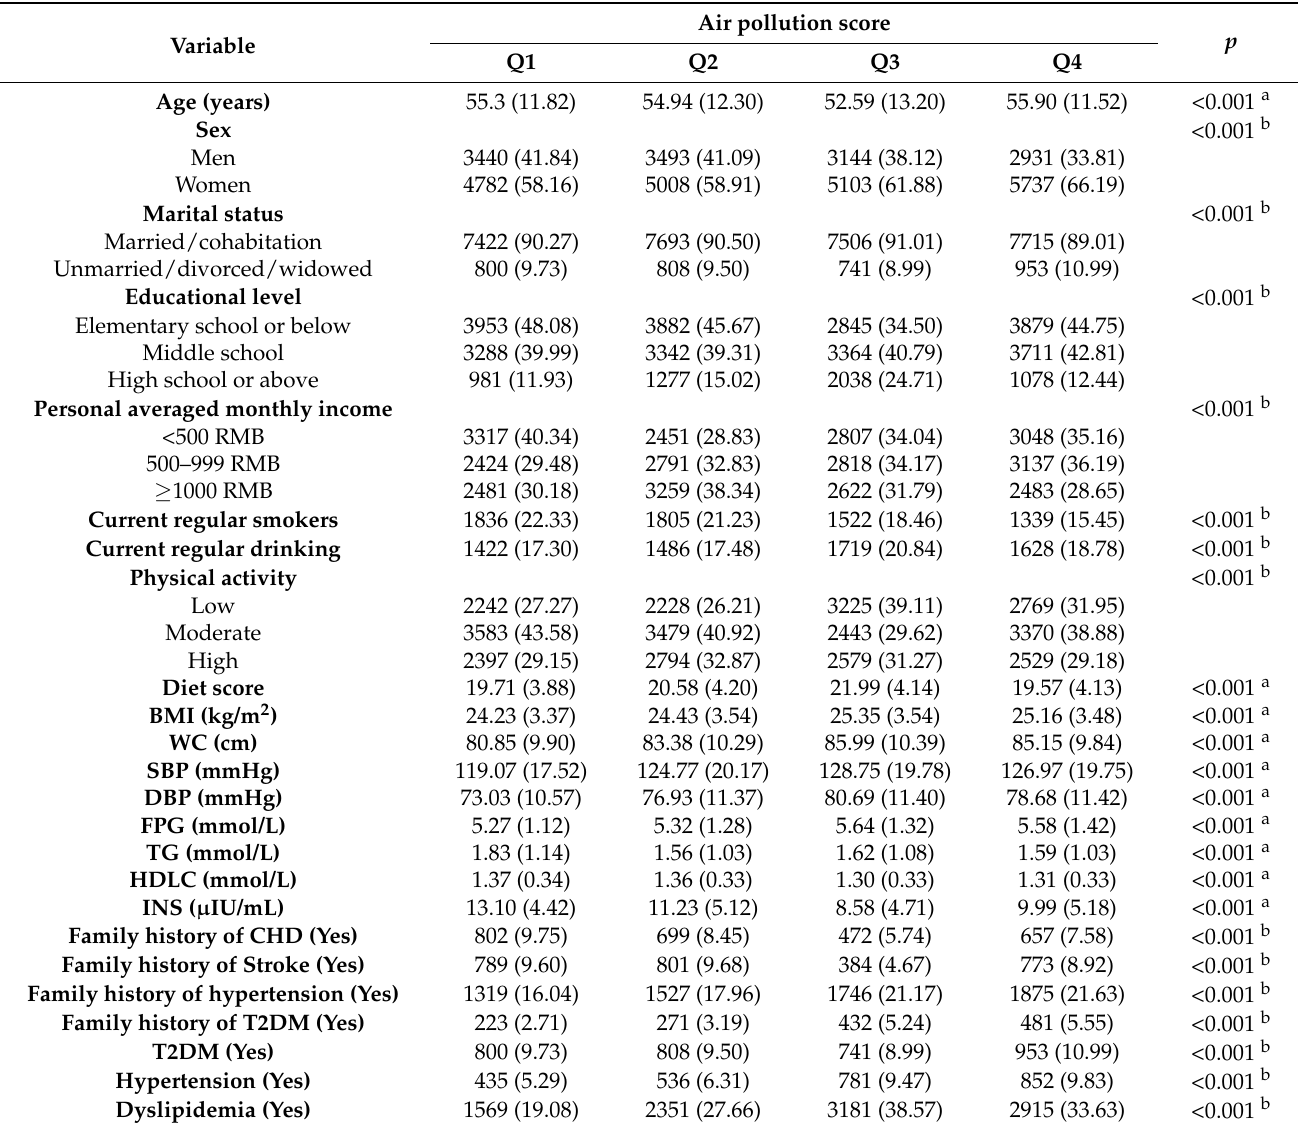
Table 1. Summary statistics of the characteristics for the participants according to the quartiles of the air pollution